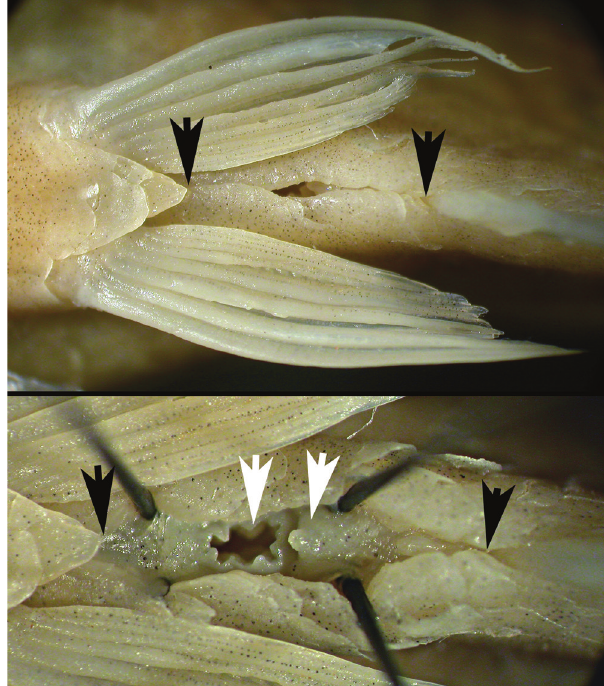
Fig. 9. Hollandichthys taramandahy , MCP 25273, paratype, male, 79.4 mm SL. Ventral body cavity between the pelvic and anal fins. Above: fissure visible ventrally (black arrows indicate its anterior and posterior limits). Below: body cavity opened with pins, showing the anus (left white arrow) and urogenital papilla (right white